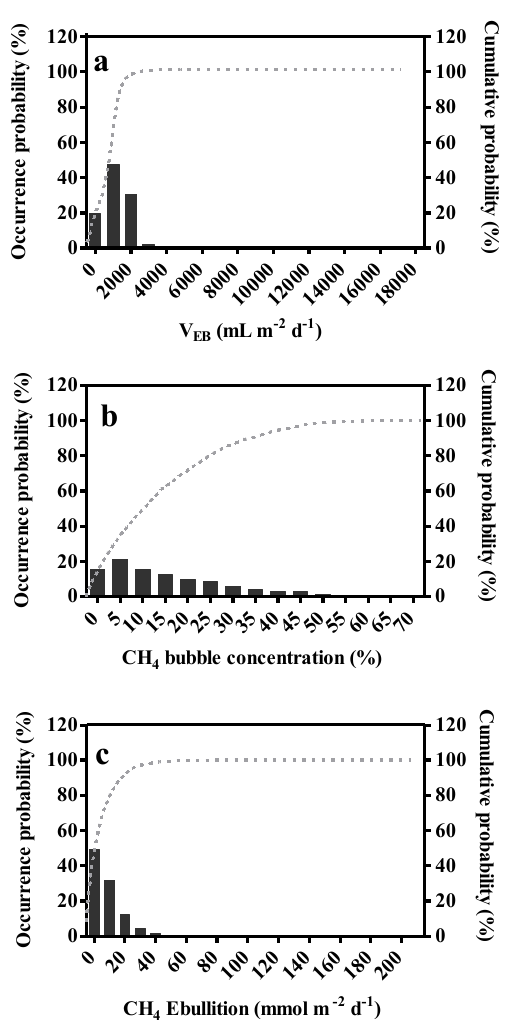
Figure 6. Histograms showing the distribution of (a) ebullition rate, (b) CH 4 bubble concentration, and (c) ebullition measured by funnels.